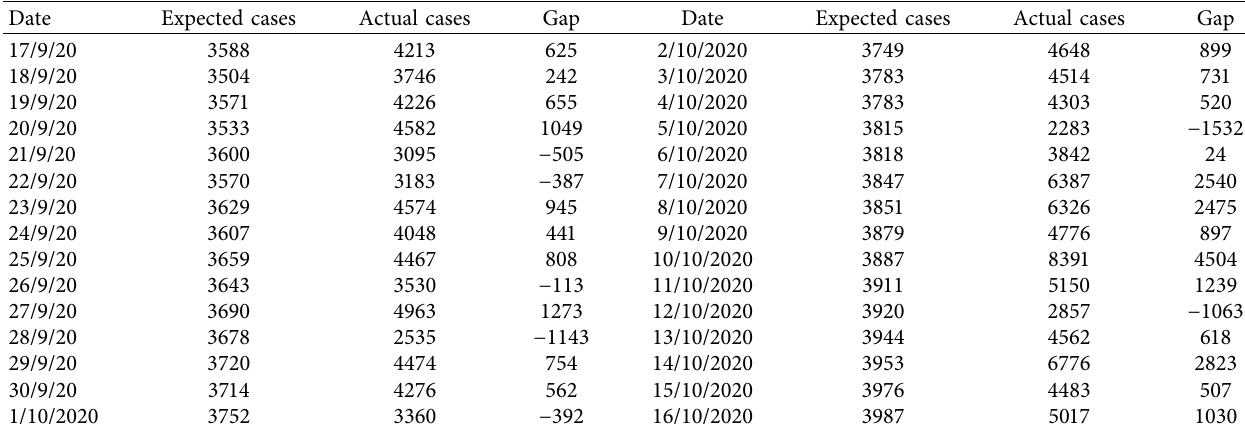
Source: own computation, 2021. Table 13: The deviation between the actual and forecasted values of the daily confirmed COVID-19 cases in North Africa for the period between 17/9/2020–16/10/2020.